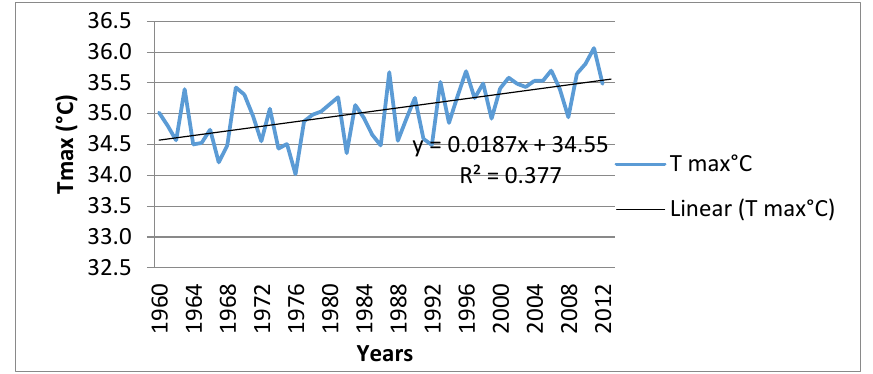
Figure A2. Minimum temperature trends during 1960–2012 at Ouagadougou.